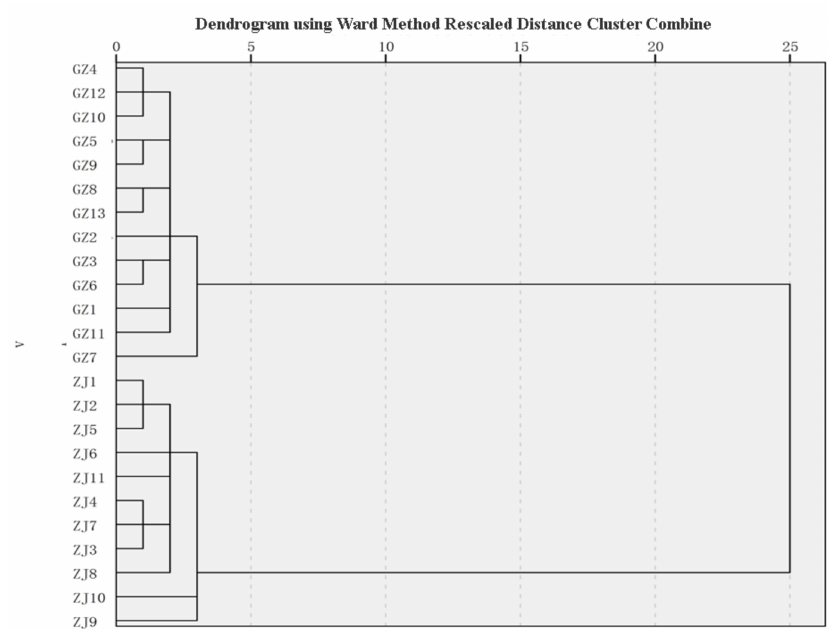
Figure 4. Hierarchical cluster analysis (HCA) of 24 samples of Selaginella doederleinii from two districts using Ward’s method based on the Euclidean